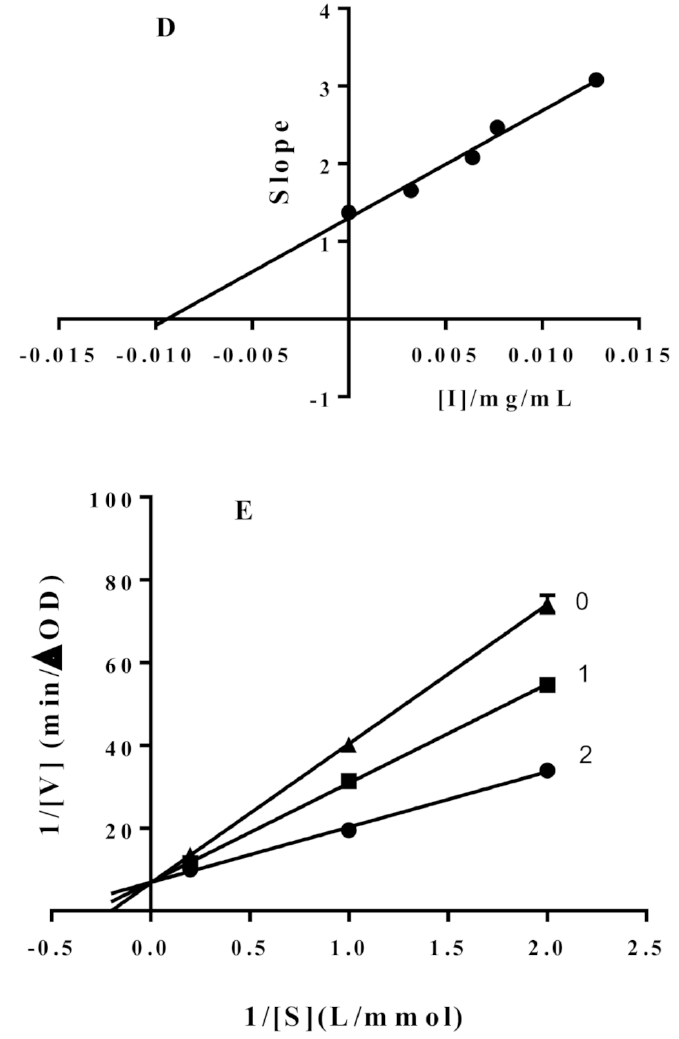
Figure 1. Inhibitory effect of hypericin on α -glucosidase activity ( A ); inhibitory mechanism of hyper- icin on α -glucosidase activity ( B ), hypericin concentrations in curves 0-4 were 0, 1.25, 2.5, 5, 10 mg/L, respectively; inhibitory type of hypericin on α -glucosidase activity ( C ), hypericin concentrations in curves 0-4 were 0, 1.25, 2.5, 5, 10 mg/L, respectively; inhibition constants ( D ) of hypericin on α -glucosidase; Inhibitory type of acarbose on α -glucosidase activity ( E ), acarbose concentrations on curves 0–2 were 0, 250, 500 mg/L,